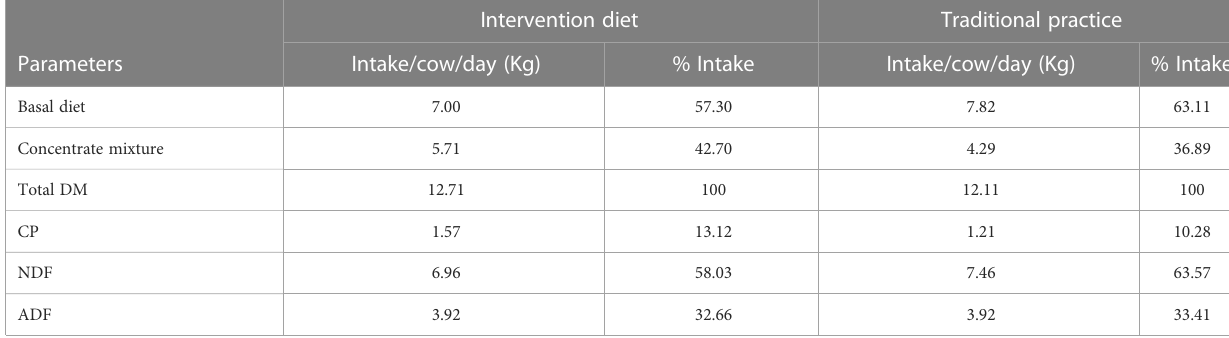
TABLE 3 Dry matter and nutrient intake for the intervention and traditional feeding practice.